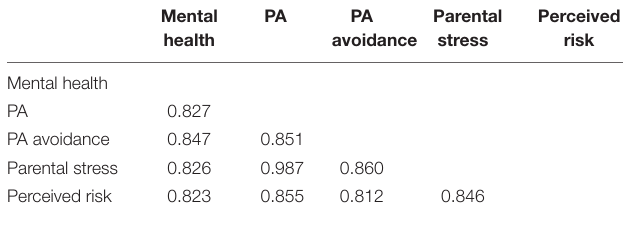
TABLE 4 | Heterotrait-Monotrait (HTMT)